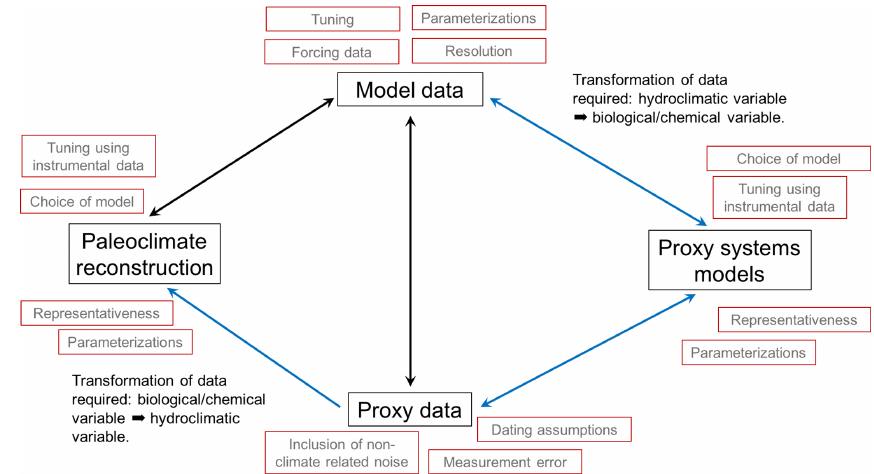
Figure 9. The black boxes show the data sources and the transformations between data sources that are required for paleoclimate proxy– model comparisons. The red boxes show the sources of uncertainty for each data source or data transformation step. The arrows show the directions in which any comparisons or data transformations take place. Following the data transformation or comparison, those sections with red arrows result in variables that are not explicitly associated with hydroclimate, and further interpretation is required. Blue arrows show where data have been transformed into a variable that is directly relevant to